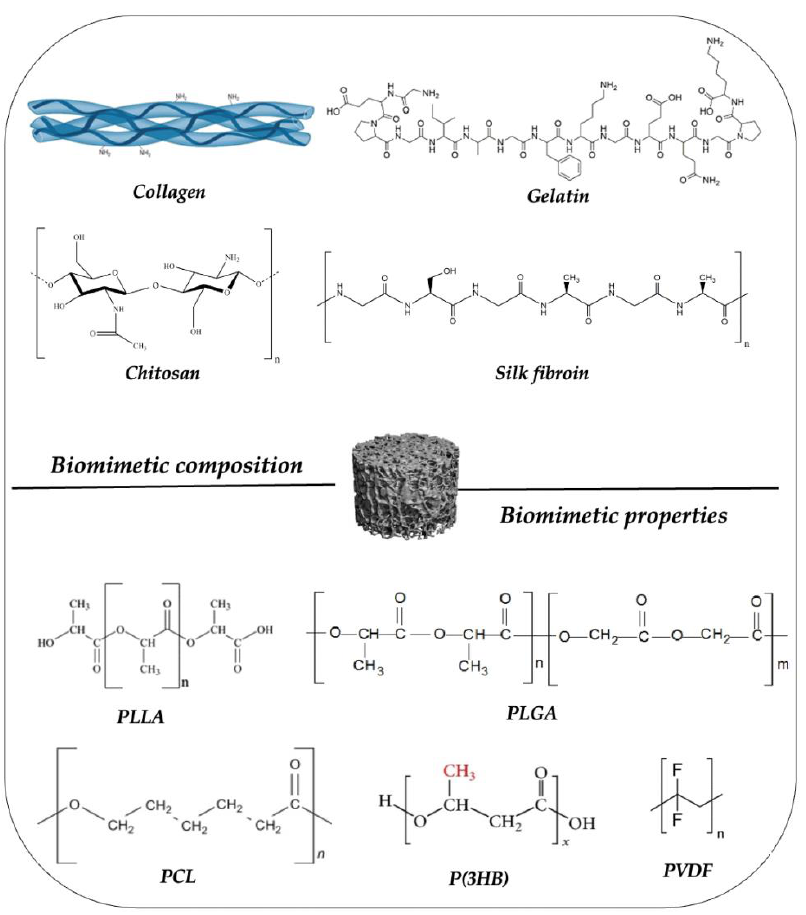
Figure 6. Natural and synthetic polymers used for magnetic scaffolds formulation and preparation.